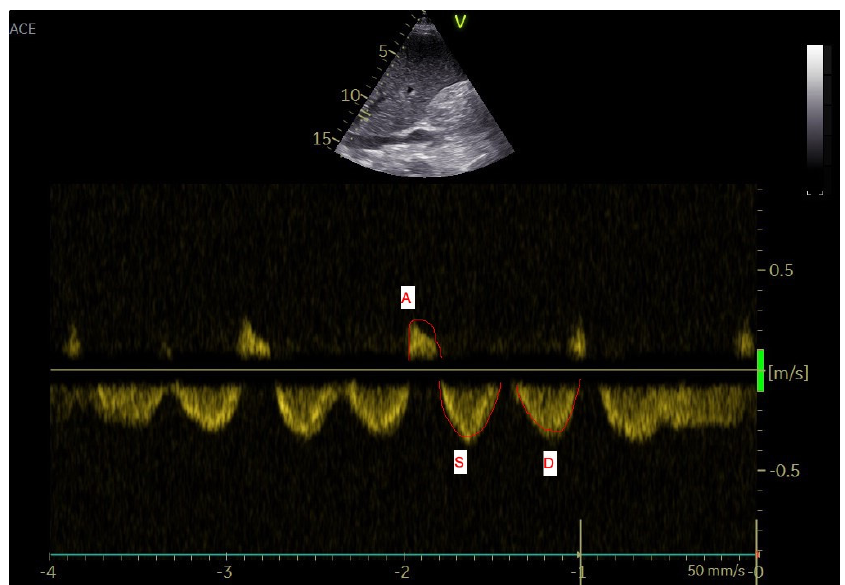
Figure 2. Doppler US analysis of the hepatic veins–maximum velocity and velocity-time integral were measured (a line was adjusted to the maximum point and continuous wave Doppler’s spectral curve was calculated by the machine. A and V waves are retrograde, S and D are anterograde waves).